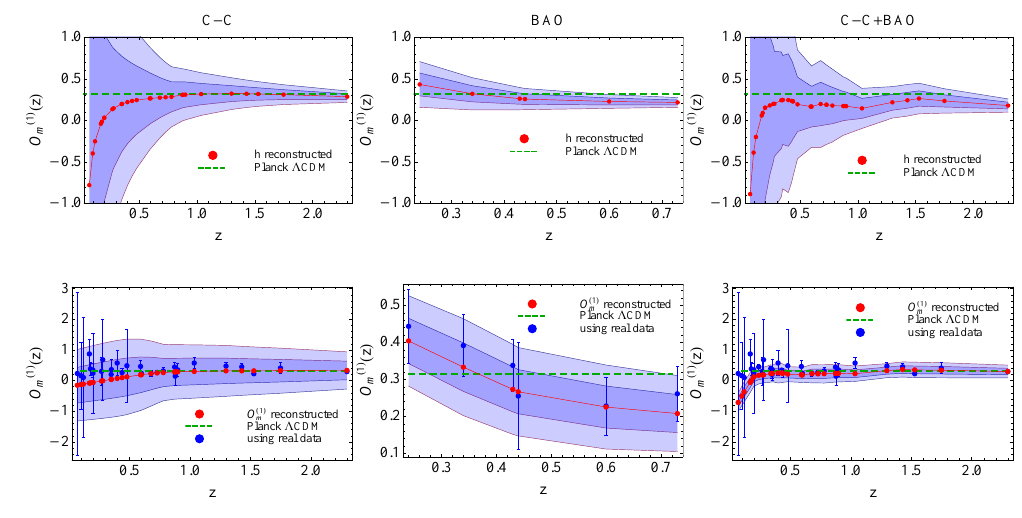
( 1 ) Figure 3. Reconstruction of the O m diagnostic for C-C data ( left column), BAO data ( middle column) and C-C+BAO data ( right column). The red dots (line) are (is) the Loess–Simex results for each sample. The dashed green line is Ω m = 0.315. Shaded purple areas represent the 68% and 95% confidence ( 1 ) regions. Top row: O m diagnostic with h reconstructed via Loess–Simex; Bottom row: O reconstructed directly via Loess–Simex. The blue dots are these values using h normalized with its error propagation bars.